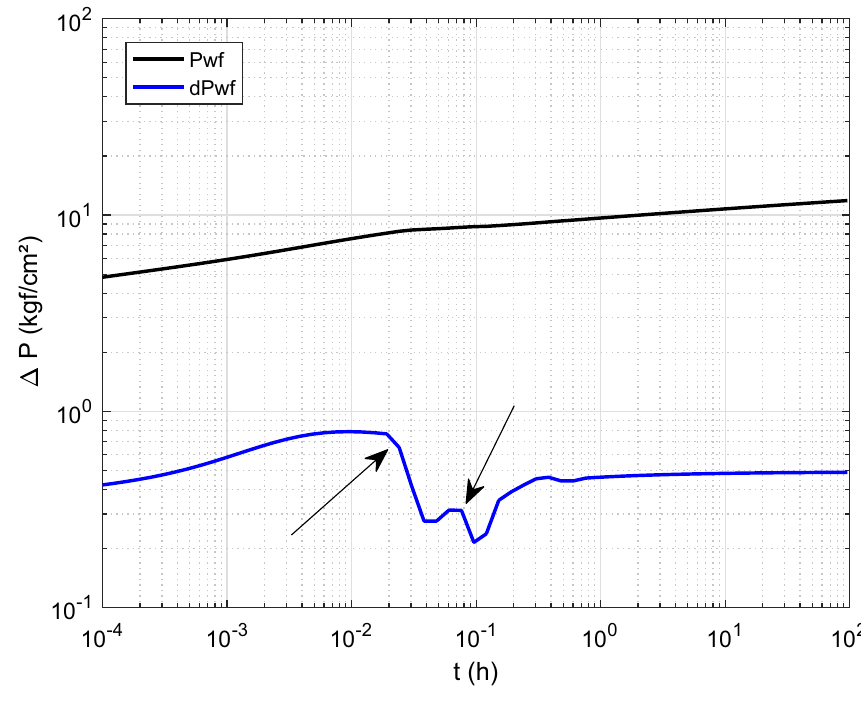
Fig. 7 Pressure and derivative data for case